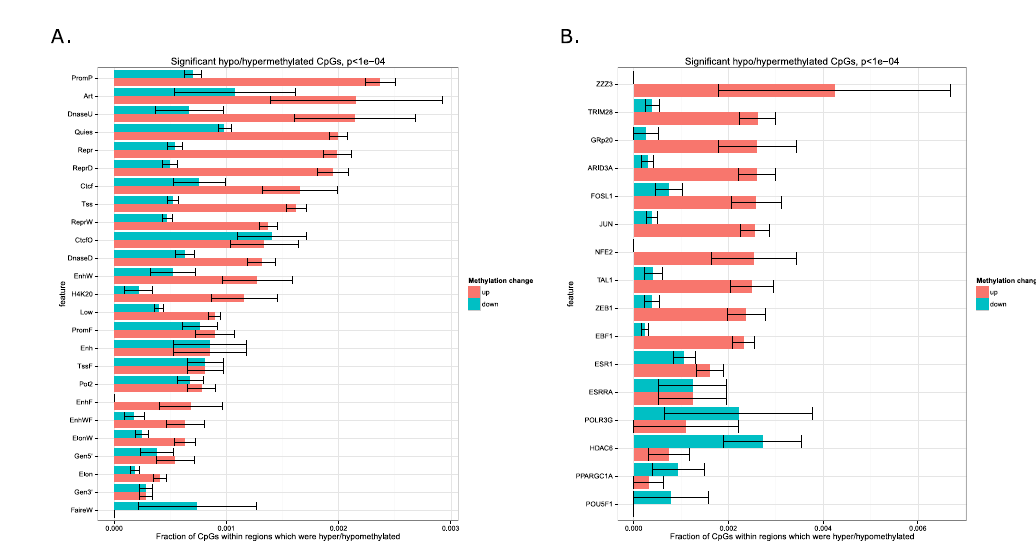
Figure 3. DMRs associated with gene TSSs. ( A ) Relation between gene expression fold-change and the change in DNA methylation within a DMR located near gene TSS. Gene names are shown for the genes with high changes in expression or promoter DNA methylation. ( B ) Gene expression of transcription-related genes which were associated with a significantly hypermethylated DMR. ( C ) Gene expression of SALL3, known to interact with DNMT3A, is significantly decreased in Caki-1 VHL * cells. Expression of DNMT3A itself was not affected.